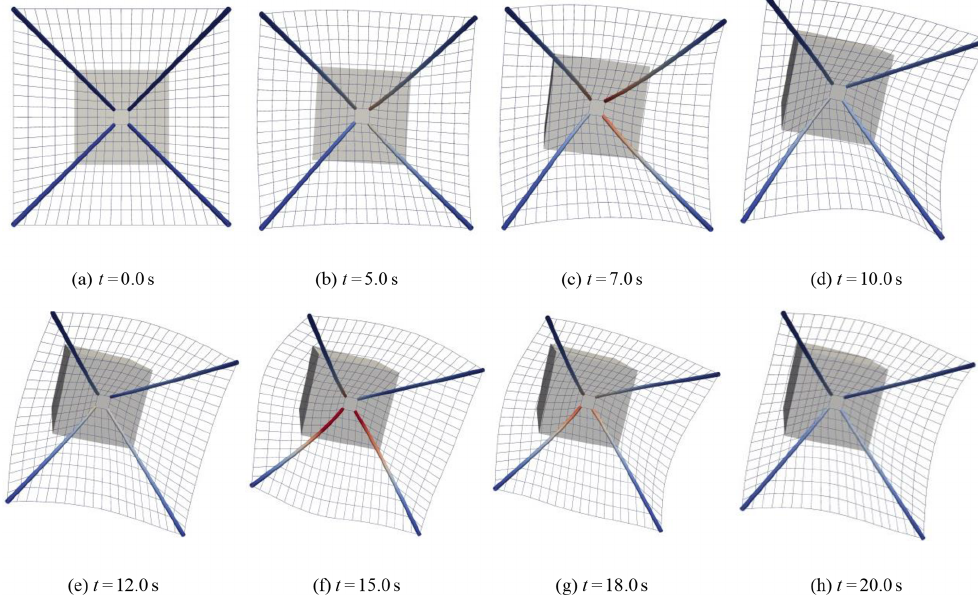
Figure 15. Procedure for attitude maneuvering.